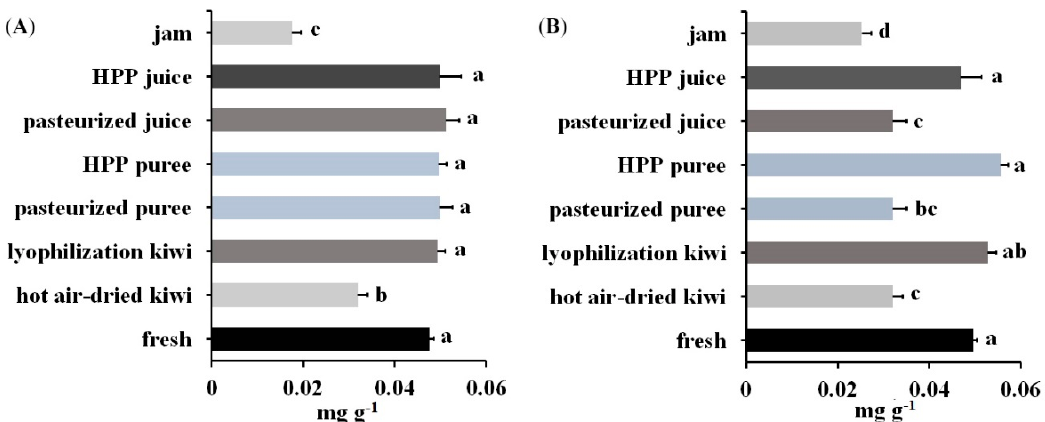
Figure 6. Content of ( A ) Act d 1 and ( B ) Act d 5 in one gram of kiwi foods produced by different processing. There was no significant difference between treatments with the same letter ( p -value < 0.05. n = 3).